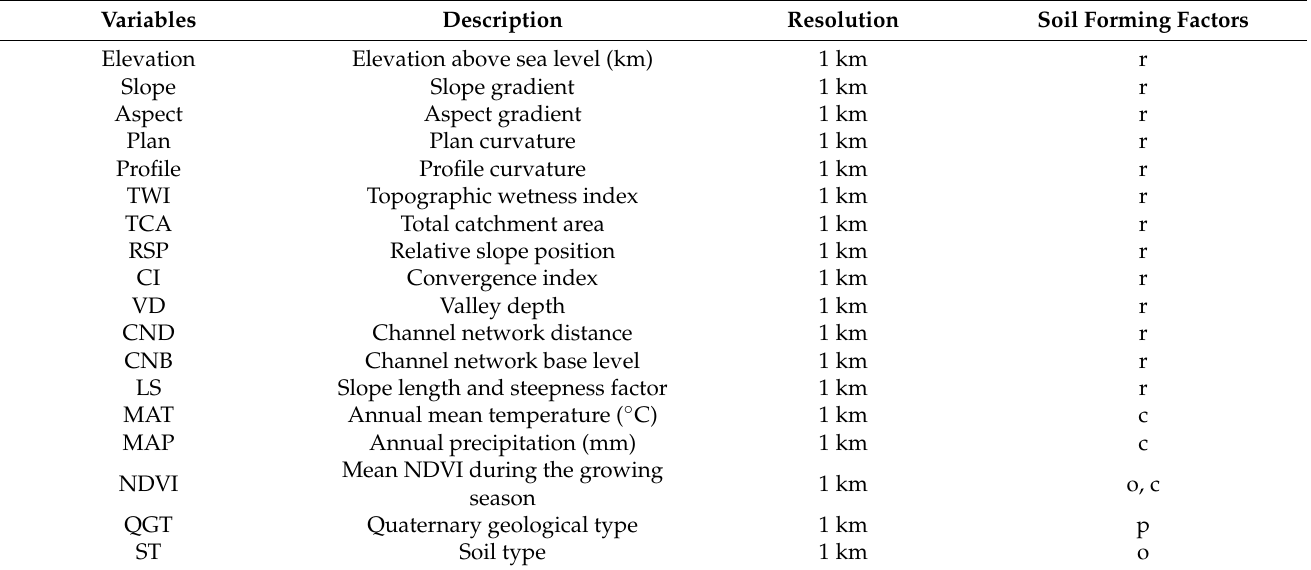
Table 1. Description of the selected